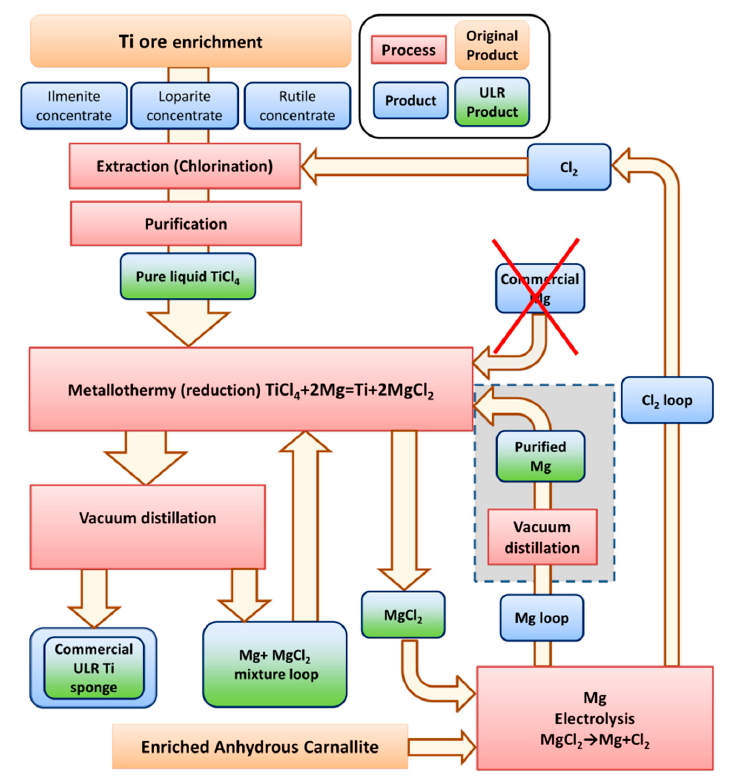
Figure 5. Modified scheme of ultra-low radioactivity Ti sponge production.